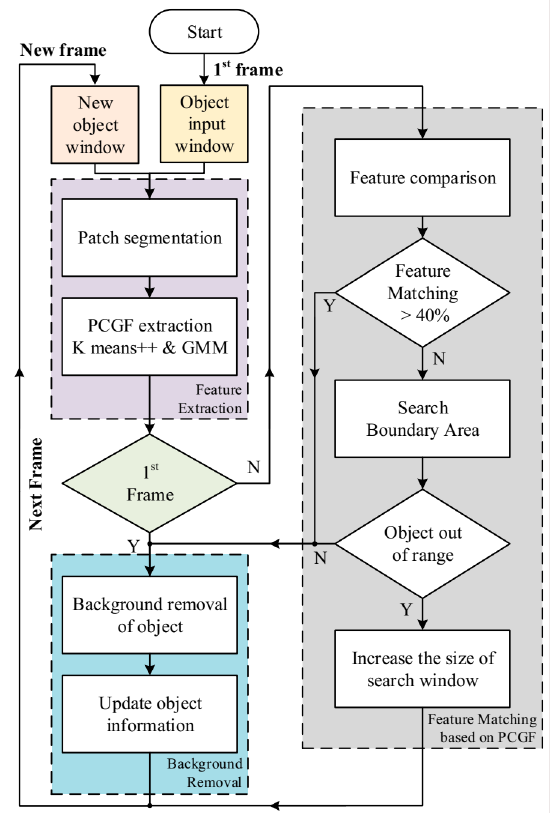
Figure 1. Proposed UAV object tracking algorithm